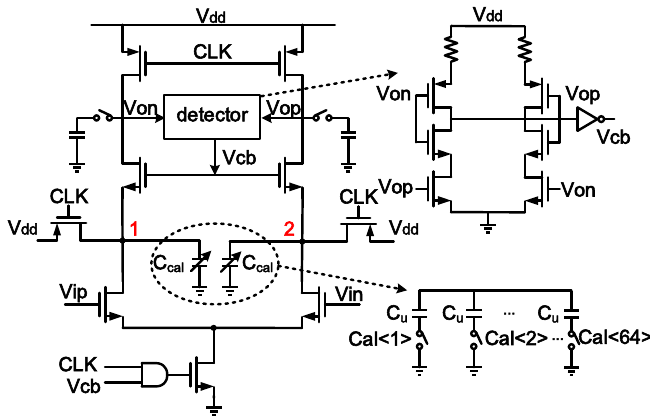
Figure 5. Circuit schematic of the DRA with calibration capacitors.